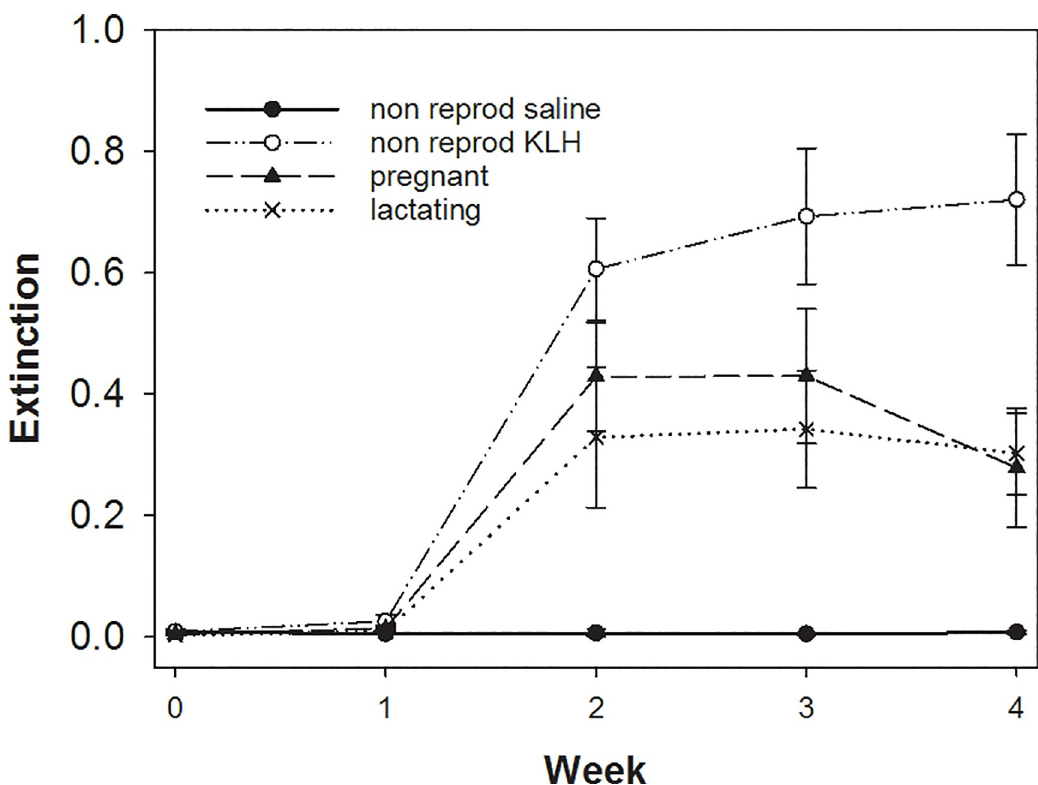
Fig 2. Differences in adaptive immune response across the 4 weeks measured by KLH-Elisa by females in Experiment II. Plotted are means and SE. For details see text.